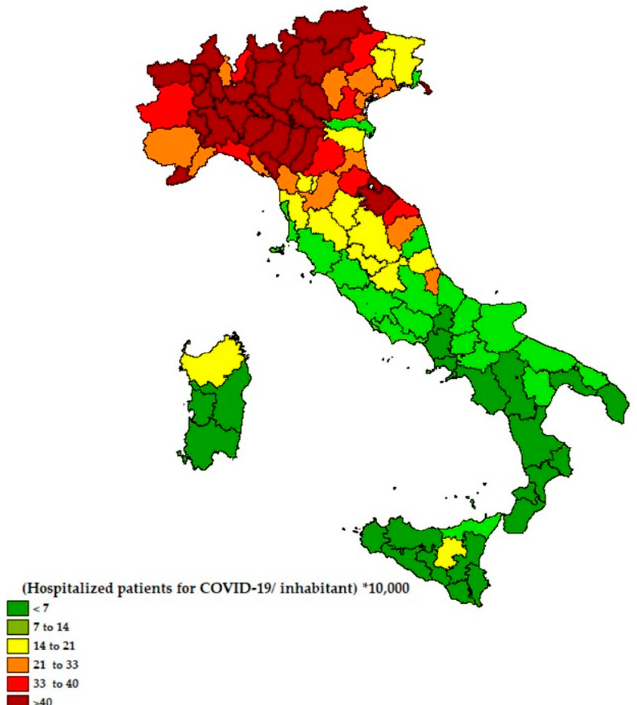
Figure 1. The ratio of hospitalized patients per inhabitant for each Italian province since the beginning of the epidemic to 27 July (number of people hospitalized for COVID-19/resident ∗ 10,000).